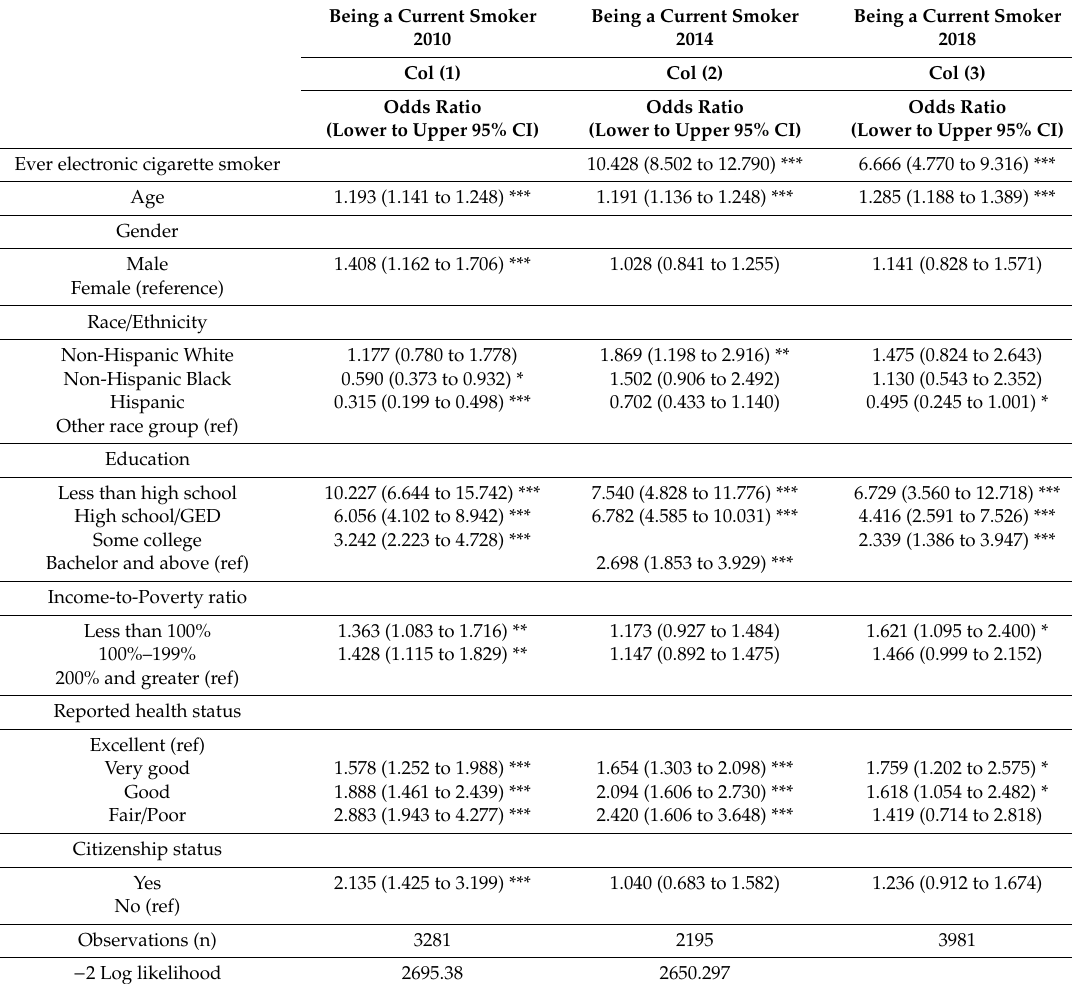
Table 3. Predicting Smoking Behaviors by Using Logistic Regressions, NHIS